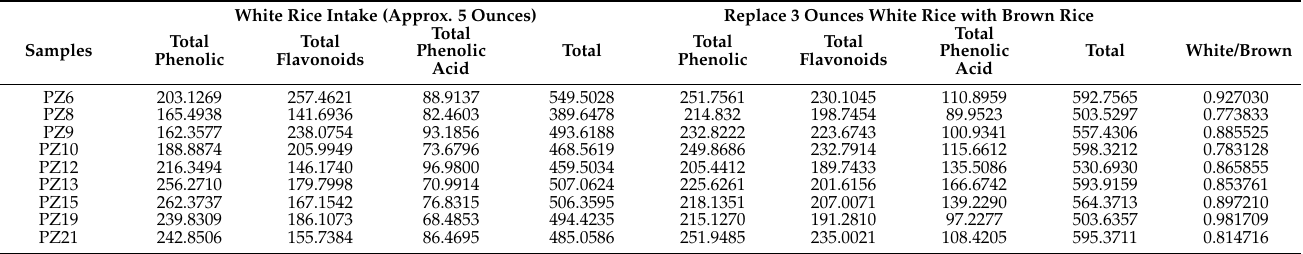
Table 4. Individual phenolic acids and flavonoids intake (mg/sp/day) from white rice and brown rice on a recommended